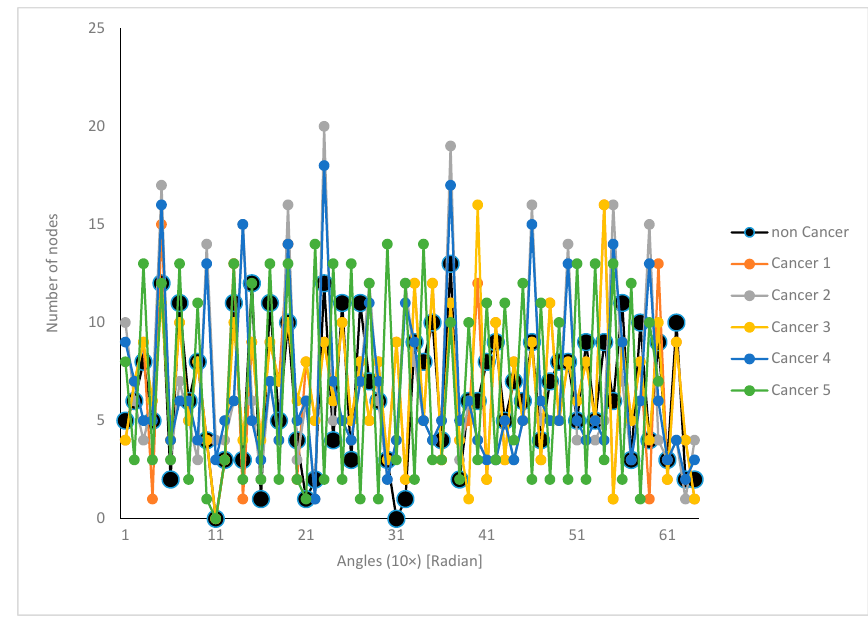
Figure 10. Comparison graph Γ ( ϕ i , j ) of sequence ( ϕ i , j ) from DNA sequences between non cancer and cancer rs10645014 [C>T].